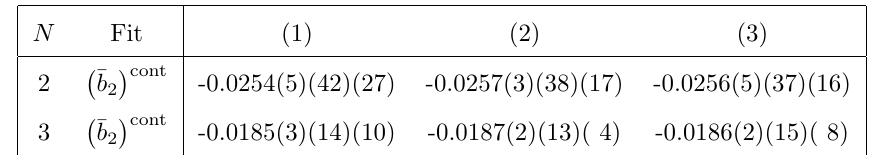
(cid:0) (cid:22) (cid:1) cont Table 8 . Results for b 2 from (cid:12)ts (1) to (3) (see text). The (cid:12)rst error is the statistical uncertainty, the second one the one associated with the unknown higher order correction terms in the potential and the third one the one due to the choice for R min .